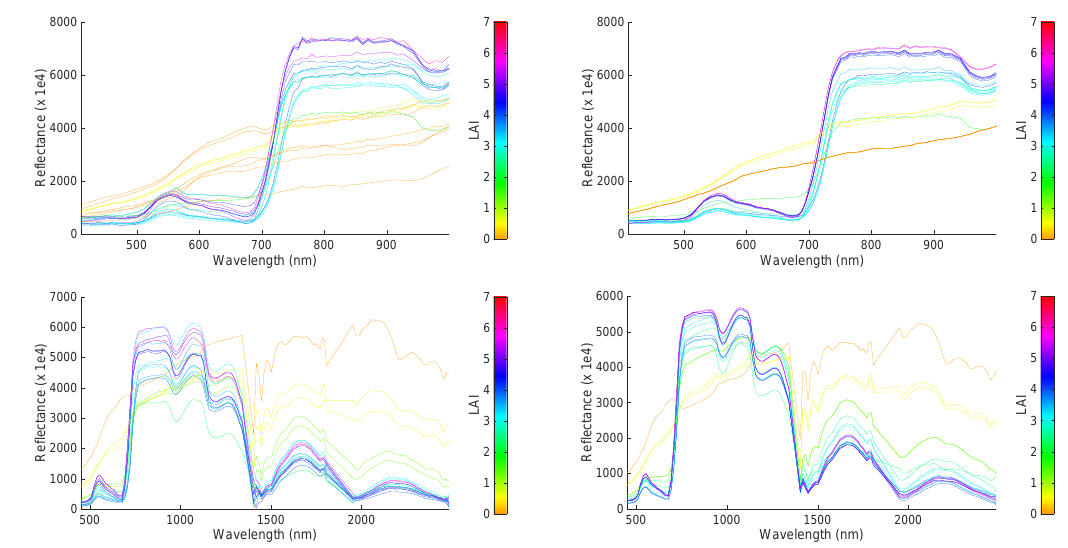
Figure 2. Original SPARC 20% validation spectra ( left ) and GPR-emulated spectra ( right ) for CHRIS ( top ) and HyMap ( bottom ) data, color plotted as a function of LAI.